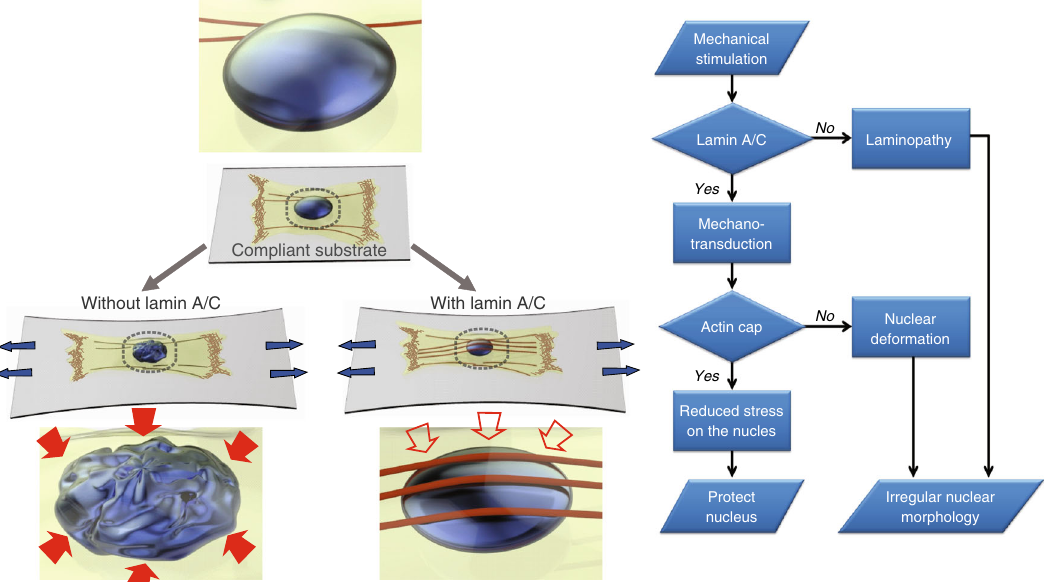
Fig. 6 Summary of the functional interplay between lamin A/C and actin cap in response to the external physical stimuli. A schematic fl ow chart of the lamin A/C-mediated cellular mechanotransduction and the role of the actin cap in protecting nuclear morphology. The external mechanical stimuli trigger the formation of actin cap in lamin A/C-present cells, which reduces the stress transferred to the nucleus and maintains the nuclear morphology. Laminopathic cells featuring the loss of the actin cap typically display the irregular nuclear